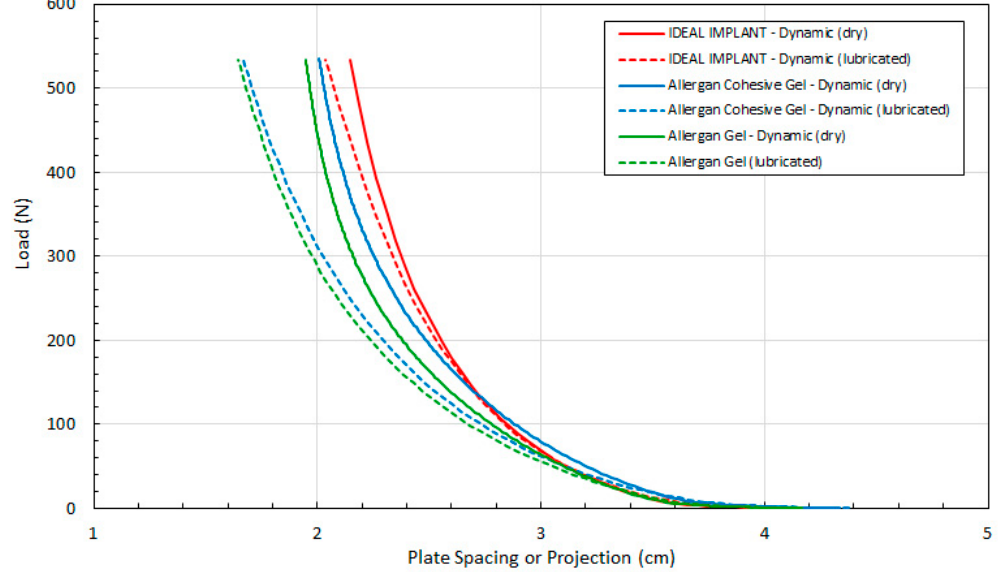
Figure 8. Load (F) as a Function of Plate Spacing (H) for Dynamic Testing, Dry and Lubricated Platens.